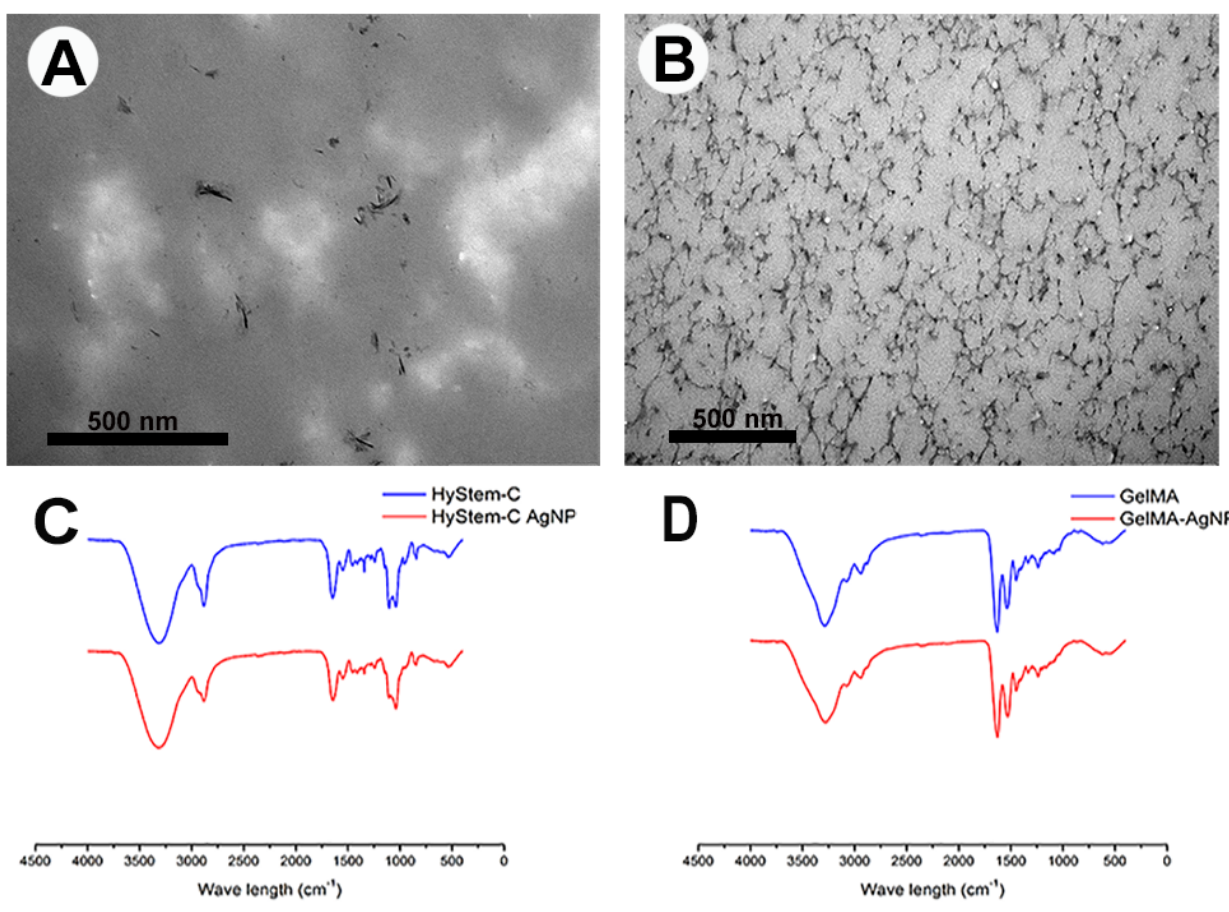
Figure 4. Top: TEM images stained with uranyl acetate and lead citrate showing distribution of 200 µ g/mL AgNPs. ( A ) Small aggregates of AgNPs in HyStem ® -C. ( B ) Well-dispersed AgNPs in GelMA. Bottom: FTIR-ATR Spectra of both hydrogels with and without 100 µ g/mL AgNP. ( C ) HyStem ® -C. ( D ) GelMA.